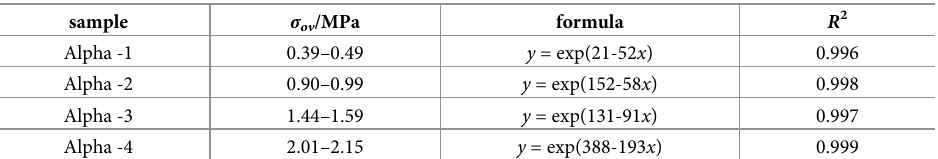
Table 4. Fit function and